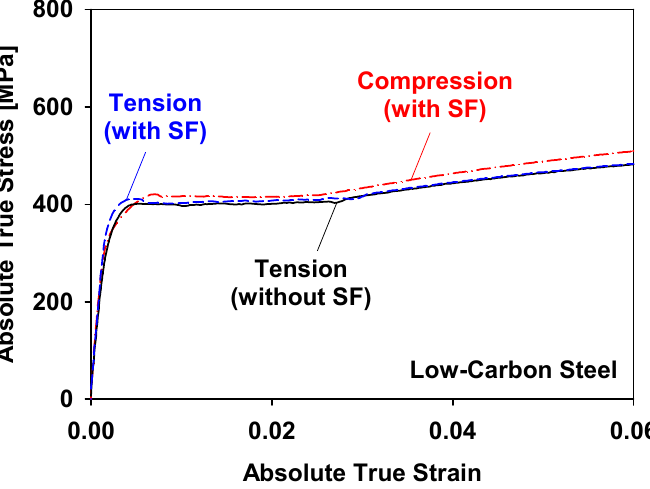
Figure 7. Apparent absolute true stress–strain curves of the low-carbon steel. Finite element simulations were performed for the tensile and compressive tests under a side force. In the FE simulation, the flow stress curve obtained from the tensile test was used in both tensile and compressive tests, assuming tension–compression symmetry. The FE calculated true stress–strain curves under side force were in good agreement with the measured stress–strain curves, as shown in Figure 8. They showed an asymmetric difference between the stress–strain curves with and without side force. This implies that the difference can be explained by mechanical factors, rather than material